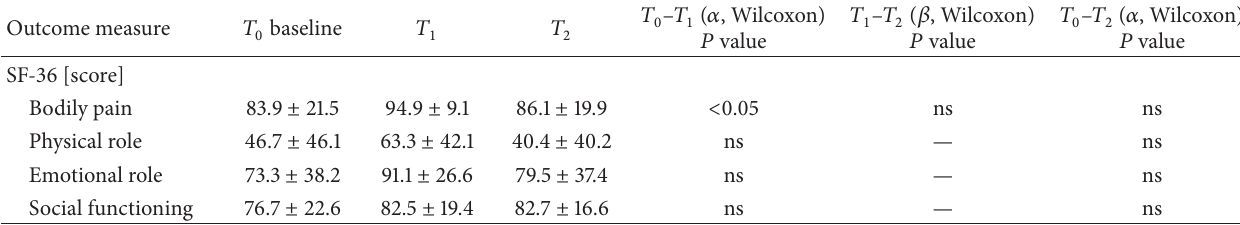
Table 6: M ± SD, reported for 𝑇 0 , 𝑇 1 , 𝑇 2 , within exercising group comparison from 𝑇 0 to 𝑇 1 using 𝑃 values ( 𝛼 , Wilcoxon test, 𝑃 ≤ 0.05); if significant 𝑃 value was reported for 𝑇 0 to 𝑇 1 , significance tests were calculated for 𝑇 1 minus 10% 𝑇 2 ( 𝛽 , paired Wilcoxon test, 𝑃 ≤ 0.05); additionally, 𝑇 0 to 𝑇 2 comparisons were calculated using 𝑃 values ( 𝛼 , paired Wilcoxon test, 𝑃 ≤ 0.05). Outcome